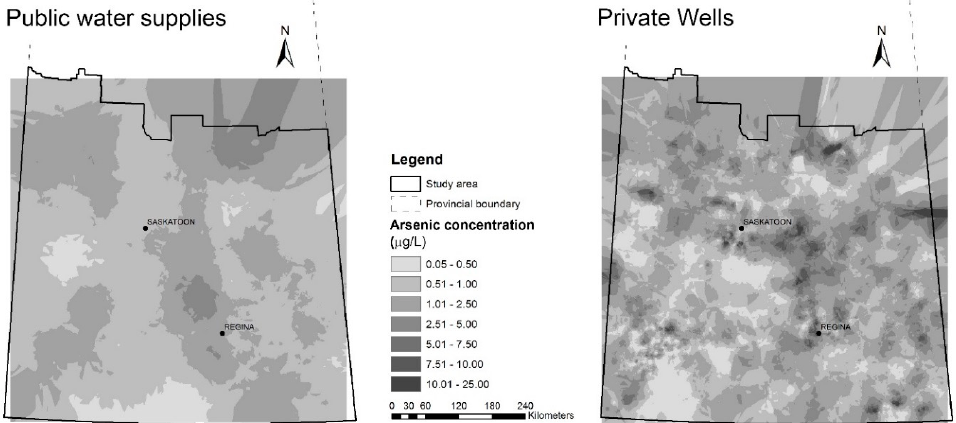
Figure 2. Arsenic concentrations ( µ g/L) predicted by empirical Bayesian kriging for: public water supply data ( left ); and private well data ( right ) in study area in southern Saskatchewan.